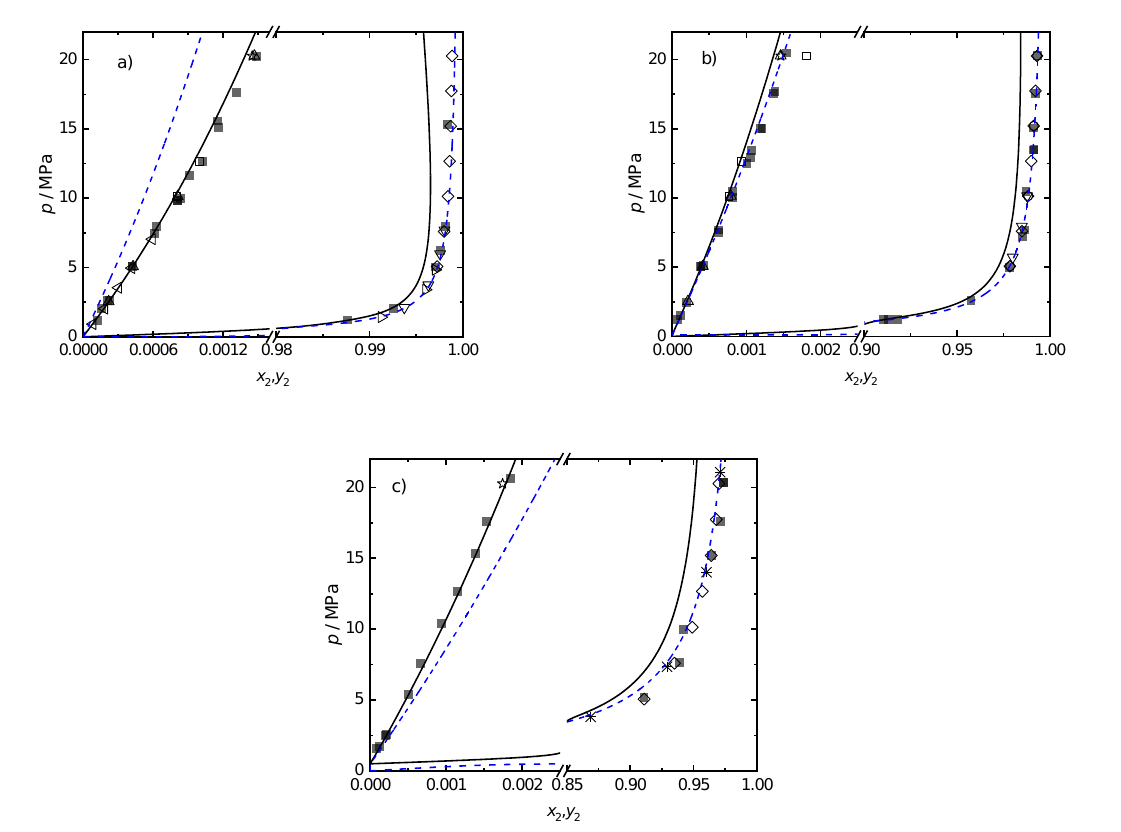
Figure 4. Vapour–liquid equilibrium for the (H 2 O(1) + N 2 (2)) system at temperatures of ( a ) 323 K, ( b ) 373 K and ( c ) 423 K. Experimental data: ■ , this work; □ , Goodman and Krase [24]; △ ; Wiebe et al. [15]; ✰ , Saddington and Krase [25]; ■ , Sidorov et al. [26]; ▽ , Rigby and Prausnitz [18]; ◇ , Maslen- nikova et al. [19]; ◁ , Chapoy et al. [39]; ▷ , Mohammadi et al. [17]; and ✳ , Tabasinejad et al. [40]. The continuous lines represent the description of the γ - φ model, and dashed lines represent the descrip- tion of the SAFT- γ Mie model.